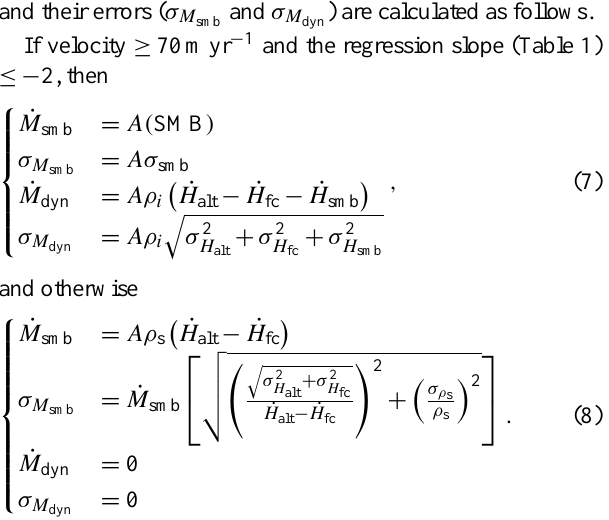
Figure 6. From left to right: σ smb , σ H through the firn